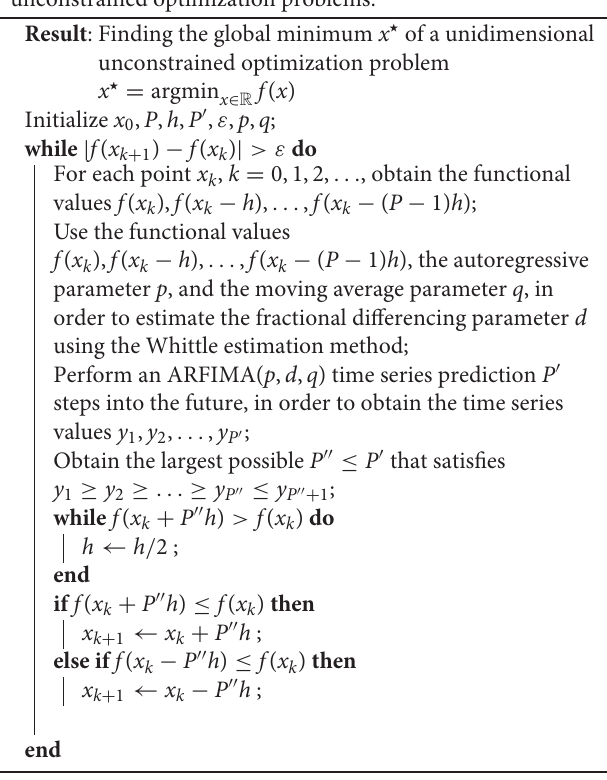
FIGURE 3 | ( Left ) Steps taken in the two-dimensional plane when the NEO method is used to find the global minimum of the function f ( x , y ) point (denoted by the red asterisk) x 0 is arbitrarily selected on the unit circle. We use ARFIMA(4, d ,0) time series predictions. ( Right ) The initial point (denoted by the red asterisk) x 0 [1 / 2 √ 3 / 2] T . We use ARFIMA(4, d ,0) time series predictions and use a constant value of d averaged out after the first 10 iterations of the method. =